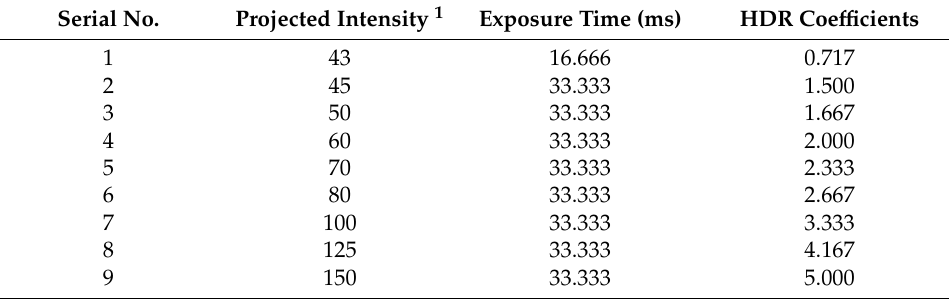
Table 1. Parameter settings of the HDR measurement.